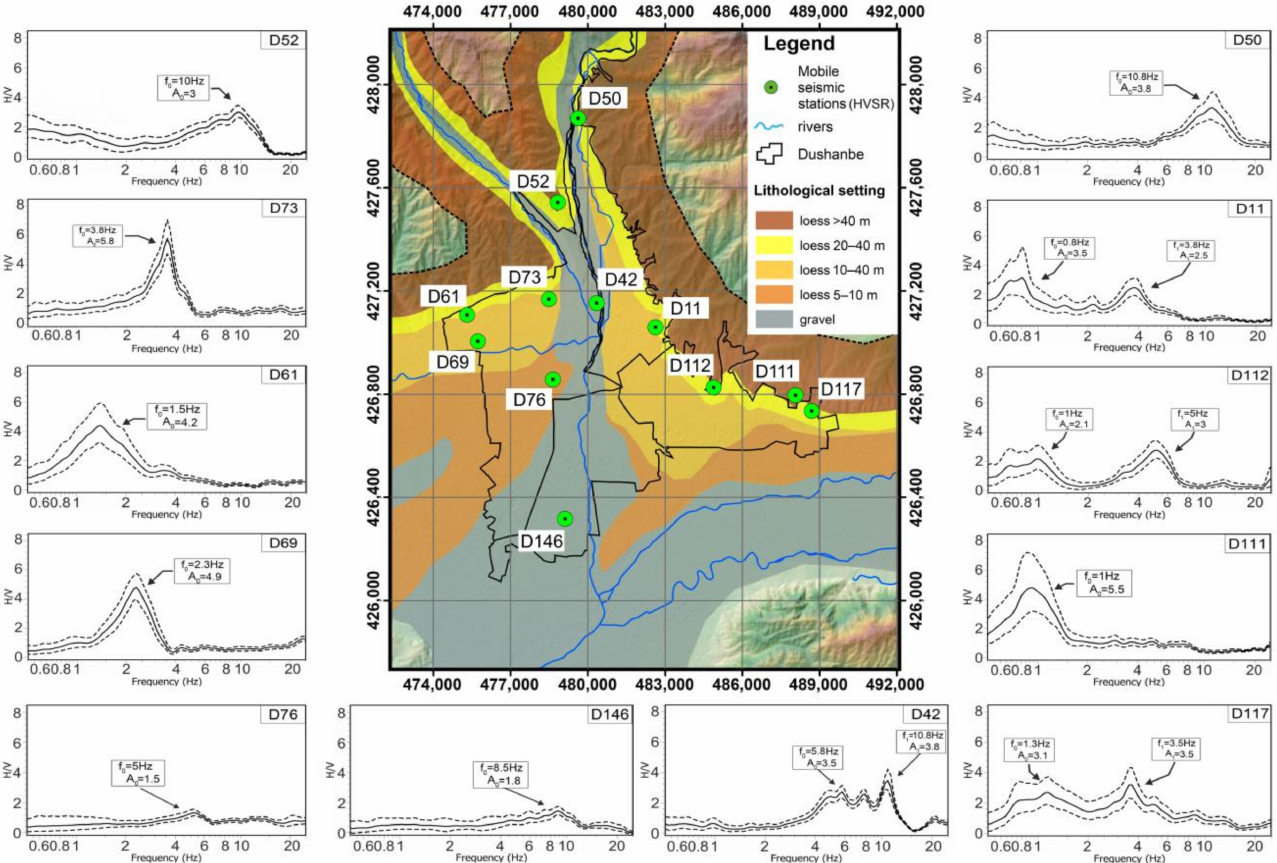
Figure 7. Selected examples of horizontal to vertical spectral ratios (HVSRs) curves showing clear peak (D50, D52, D61, D69, D73, and D111), double peak (D11 and D112) and multiple peaks (D42 and D117) with examples of flat HVSR curves that show a small peak (D76 and D146). The HVSR plot is represented by a thick black continuous line as the averaged HVSR curve, black dashed lines as HVSR standard deviation (std), its associated peak amplitude HVSR (A 0 ) with std, f 1 as secondary peak frequency of